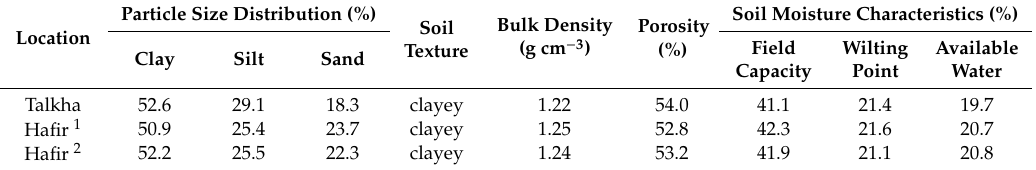
Table 2. Soil physical properties of the root zone in the experimental fields. Location